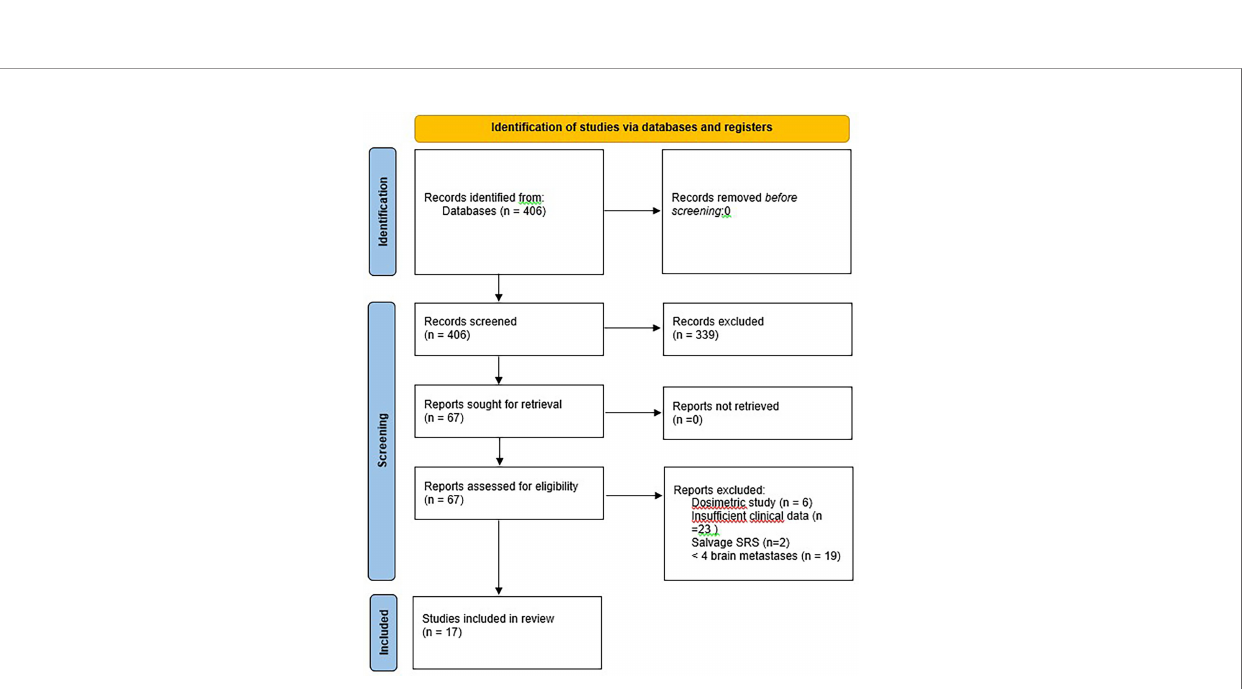
FIGURE 3 | Flow diagram representing the number of records identi fi ed and reasons for exclusion.